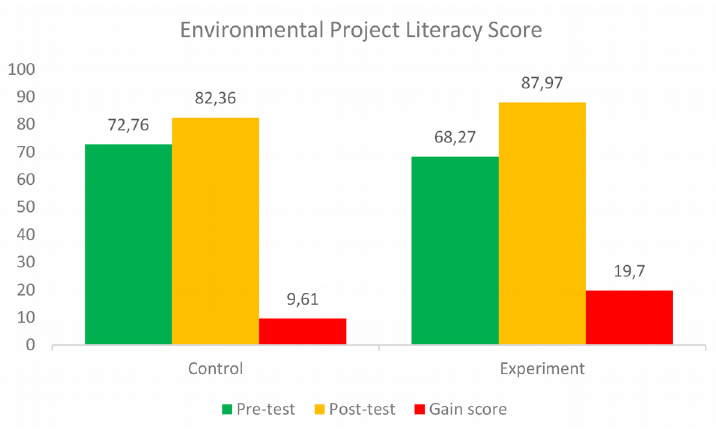
Figure 3. The Mean Gain Score of The Environmental Project Literacy